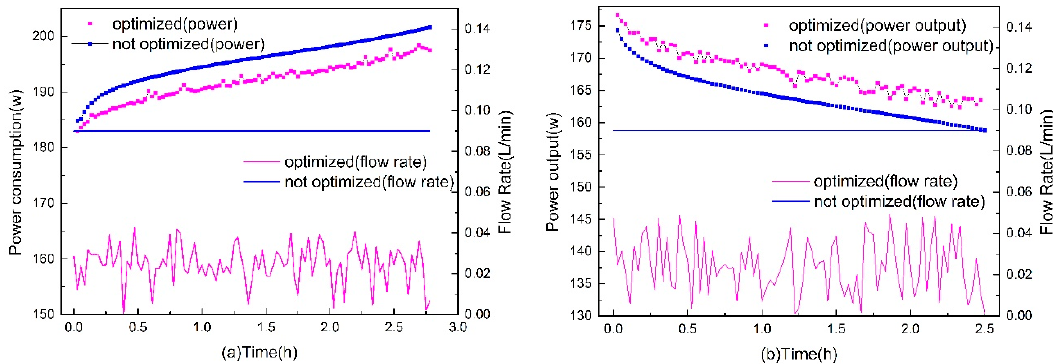
13 of 17 Figure 13. ( a ) The change of power consumption with the flow factor during charging; ( b ) the variation of output power with the flow factor during discharging. In the face of the phenomenon of charge and discharge "peak and valley" in actual engineering, there is a time-varying optimal flow factor corresponding to different charge and discharge powers under the corresponding state of charge. If a fixed flow factor is used, it may not reach the expected optimization effect. Tao W. et al. [38] combined dichotomy with the flow factor optimization method to realize real-time optimization of electrolyte flow under dynamic charging and discharging power, but this method is only applicable to single-parameter optimization, and the objective function must be a single peak function. Compared with the traditional optimization algorithm, genetic algorithm has good optimization ability for nonlinear problems, and can optimize multiobjective and multiparameter simultaneously. Therefore, the genetic algorithm is introduced as an optimization method in this paper. The constant charge–discharge power condition is taken as an example to optimize the electrolyte flow rate of the zinc–nickel single-flow battery stack in real time, which provides theoretical support for multiparameter and multiobjective optimization under dynamic charge–discharge power. In this paper, the total loss (internal loss and pump loss) of the zinc–nickel single-flow battery stack (300 Ah) energy storage system during charging and discharging process is taken as objective function, and the electrolyte flow rate was optimized at each time step in the simulation model. Figure